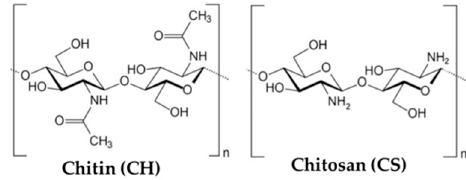
Figure 9. The structure of chitin and